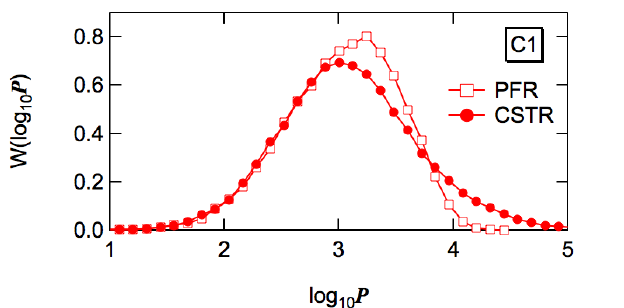
Figure 2. Weight fraction distribution of polymers formed in a PFR and in a CSTR, when the average branching density, as well as the average scission density, is set to be the same for both types of reactors [12]. The kinetic parameters used are the same as C1, shown later in Table 2 of this article.